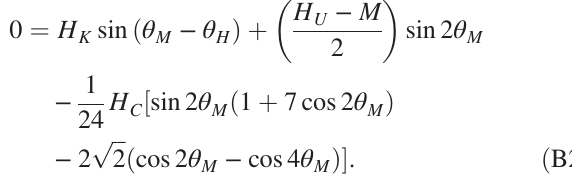
measured from V K 2